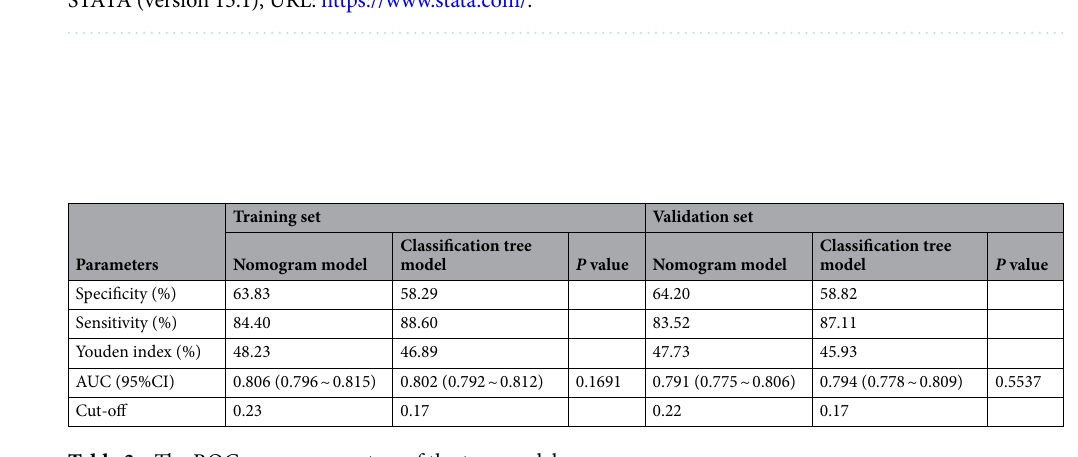
Figure 3. ROC curves of the two models in the training and validation sets. The figure was created by using STATA (version 15.1), URL: https:// www. stata. com/.